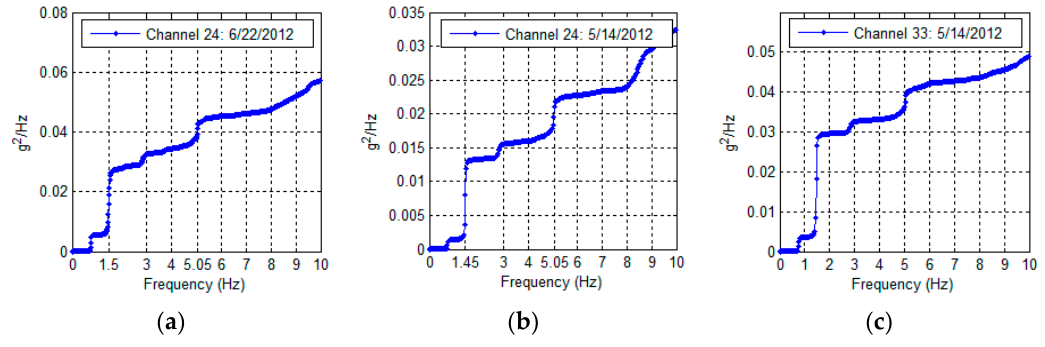
Figure 11. Cumulative spectral power at floor 12 during 22 June ambient vibrations ( a ) and the 14 May event ( b ) and cumulative spectral power at floor 19 during the 14 May event ( c ).